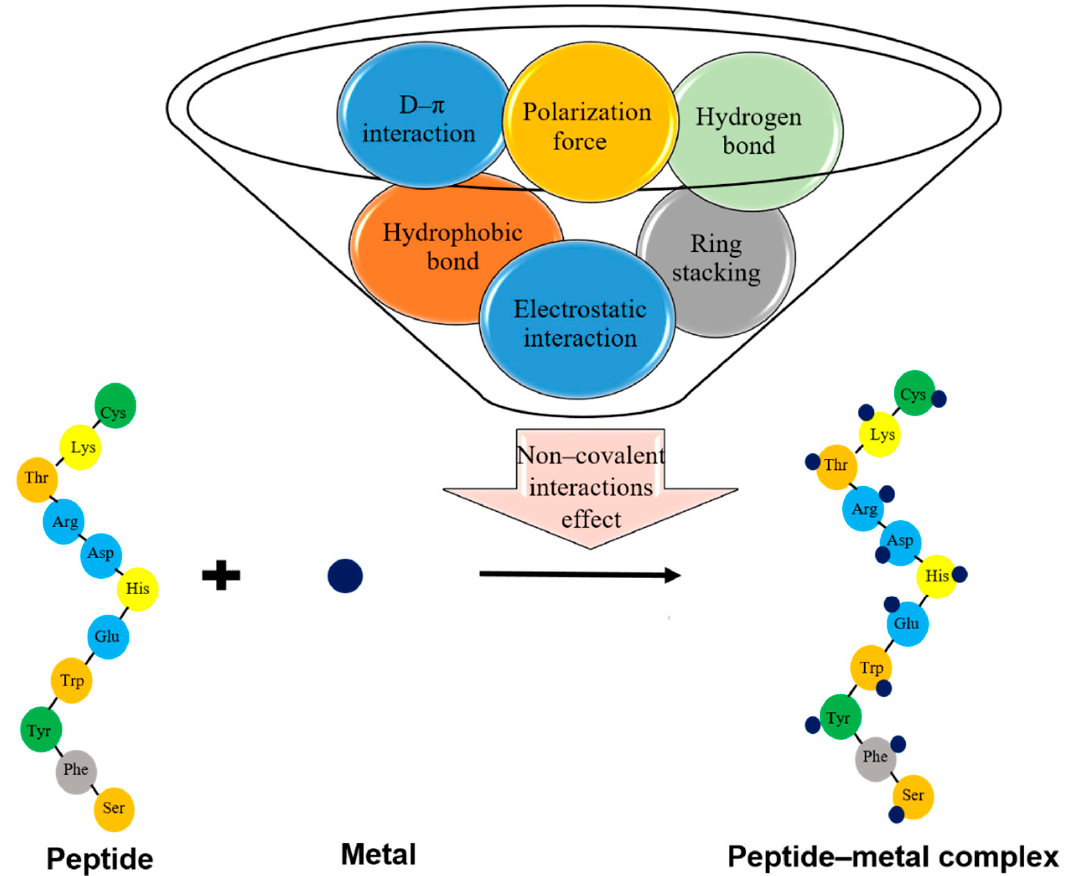
Figure 2. The chemical interactions involved in the formation of peptide–mineral complexes. The amino acids with a high tendency to bind to minerals are illustrated.